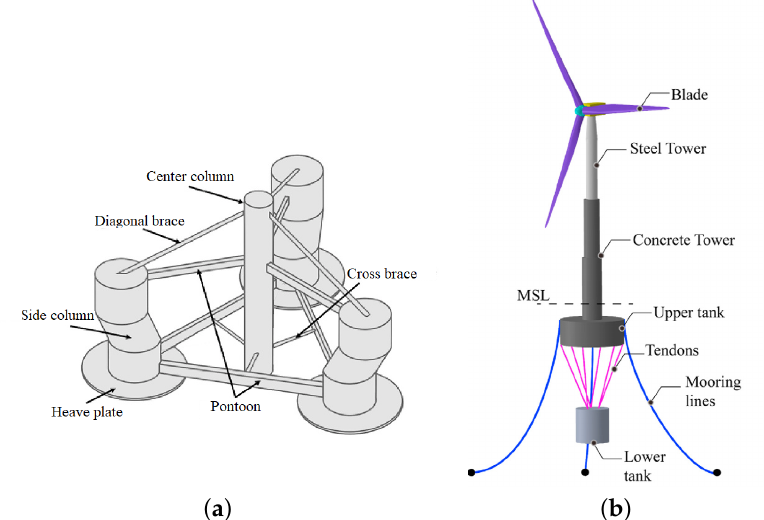
Figure 5. Novel FOWT platform design concepts. ( a ) Fully-submerged platform initial design [65]. ( b ) TELWIND platform design concept